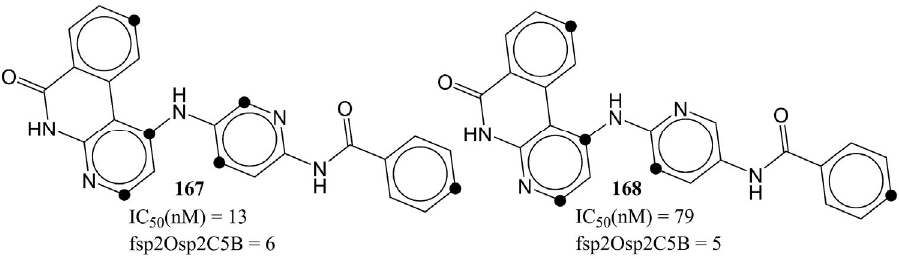
Figure 9. Representation of fsp2Osp2C5B using molecule numbers 167 and 168 as representative examples. The black circle represents the sp2-hybridized carbon at five bonds from sp2-hybridized oxygen.